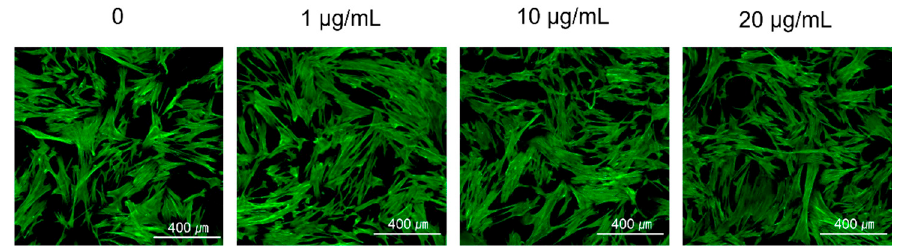
Figure 3. The CLSM image is the result of confirming the adhesion and proliferation of hMSCs.